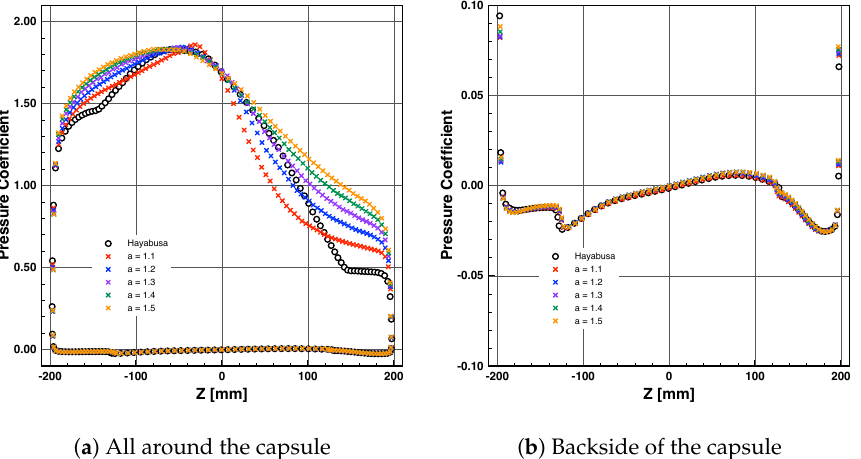
Figure 7. Pressure coefficient distribution on the symmetry plane with different hyperbolic contours at an AoA of 15 degrees.